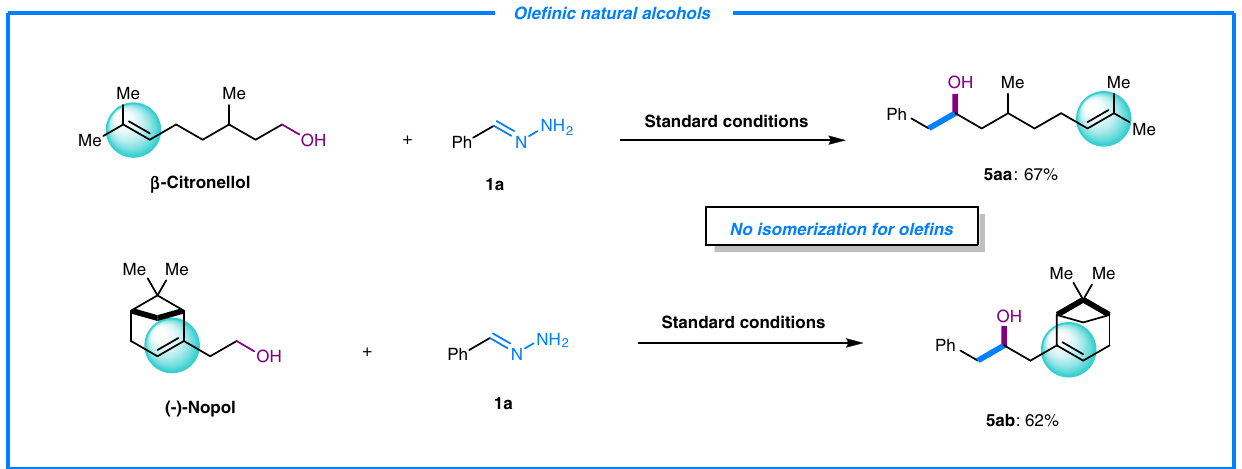
Fig. 4 Reactivity of ole fi nic natural alcohols. Standard reaction conditions: 1a (0.6 mmol), 2a (0.2 mmol), Ru(PPh 3 ) 3 Cl 2 (5 mol %), ligand (5 mol %) and K 3 PO 4 (2 equiv.) in 2-MeTHF at 70 °C under N 2 atmosphere for 24 h. See Supplementary Information (SI) for details. Some naturally available ole fi nic alcohols also reacted ef fi ciently, in which the ole fi n did not isomerize with the alcohol being the only reaction site. These two examples demonstrated the synthetic potentials, attributed to the special tolerance to ole fi ns by the ruthenium